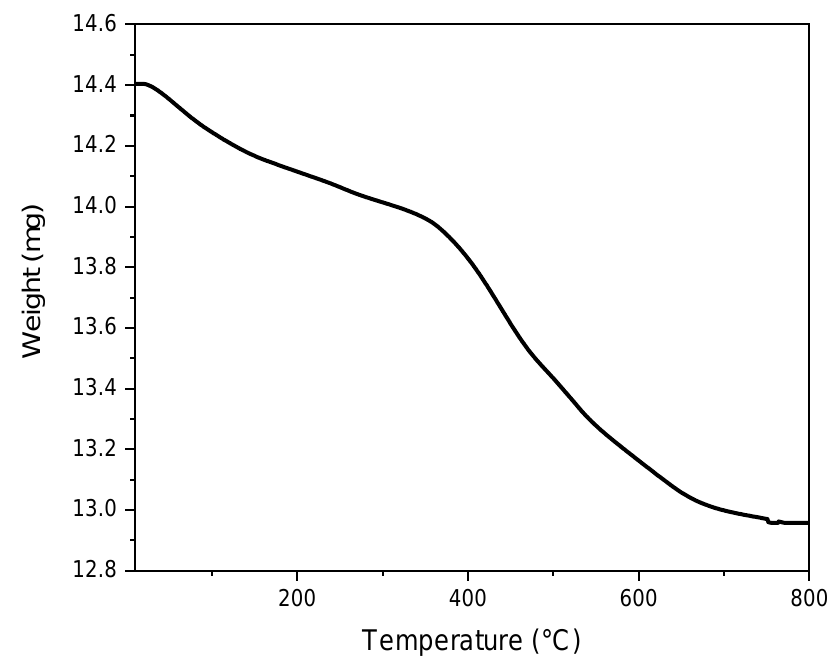
Figure 4. TG thermogram of CuO NPs.